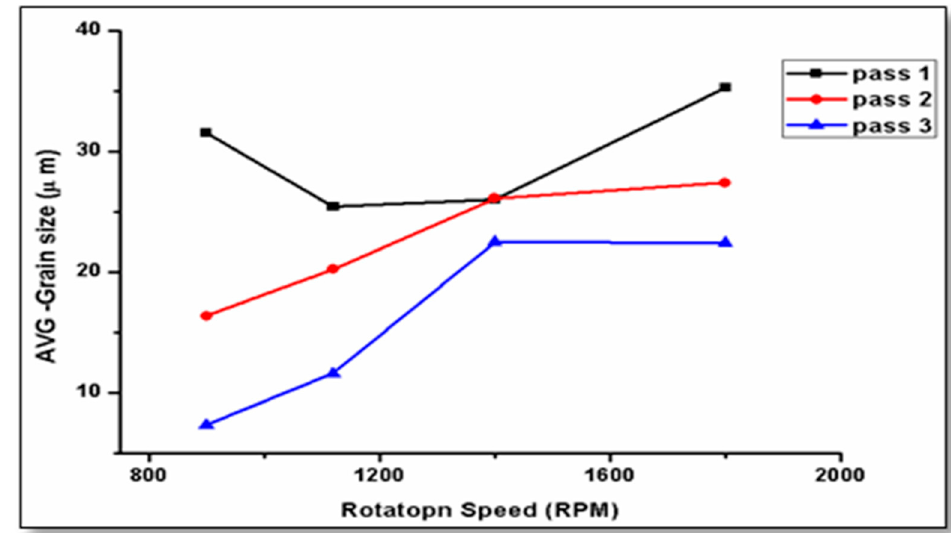
Figure 17. Effect of tool rotation speed on the average grain size, at 10 mm/min traverse speed.